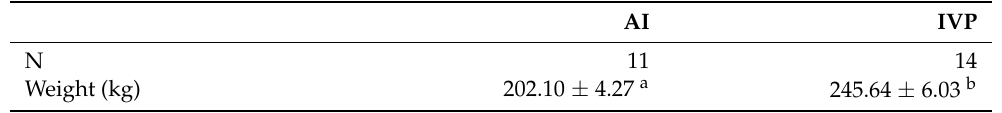
Table 1. Weight at 3.5 years of age in sows derived from artificial insemination (AI) and in vitro embryo production (IVP). Data are expressed as mean ± s.e.m.